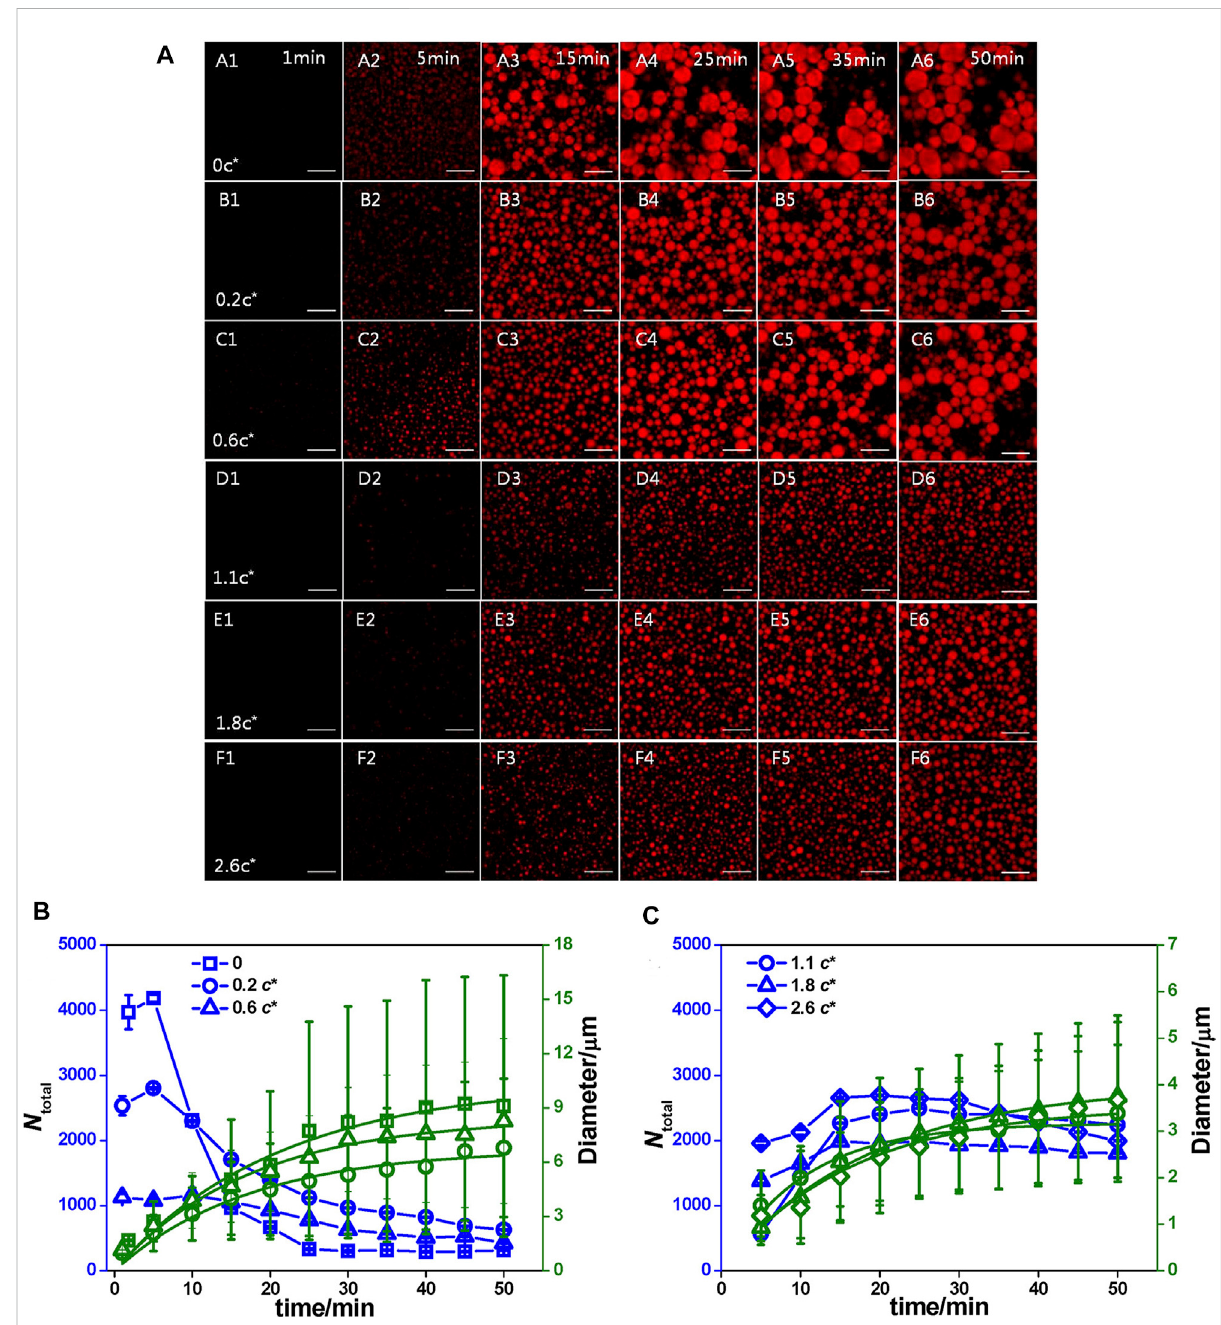
Thein fl uenceofkinetics. (A) Timedependenceofthecoacervatedropletsformedby1.0 mg/mLS5and1.4 mg/mLss-oligoinPAMsolutionsat varyingconcentrationsasdenotedbyc/c*.c*istheoverlapconcentrationsandc*ofPAMis2.7 mg/ml1×DPBSbuffer,Scalebar:25 μ m. (B) 1×DPBS buffer and PAM solution at concentrations lower than c* and (C) PAM solution at concentrations higher than c*. The blue lines are used to guide the eyes, while the green lines are the fi tting curves by equation 〈 R 〉 = (Kt)Q13 n (Bai et al., 2021). Copyright © 2020 American Chemical